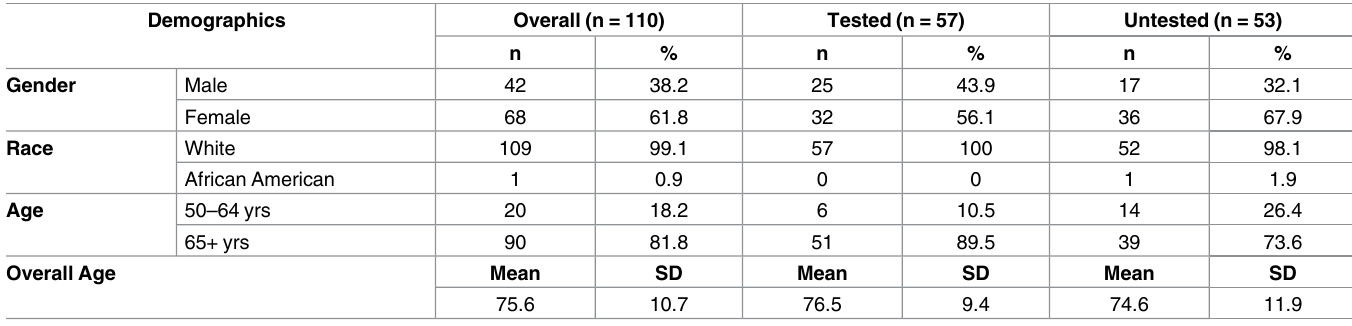
Table 1. Demographic characteristics of